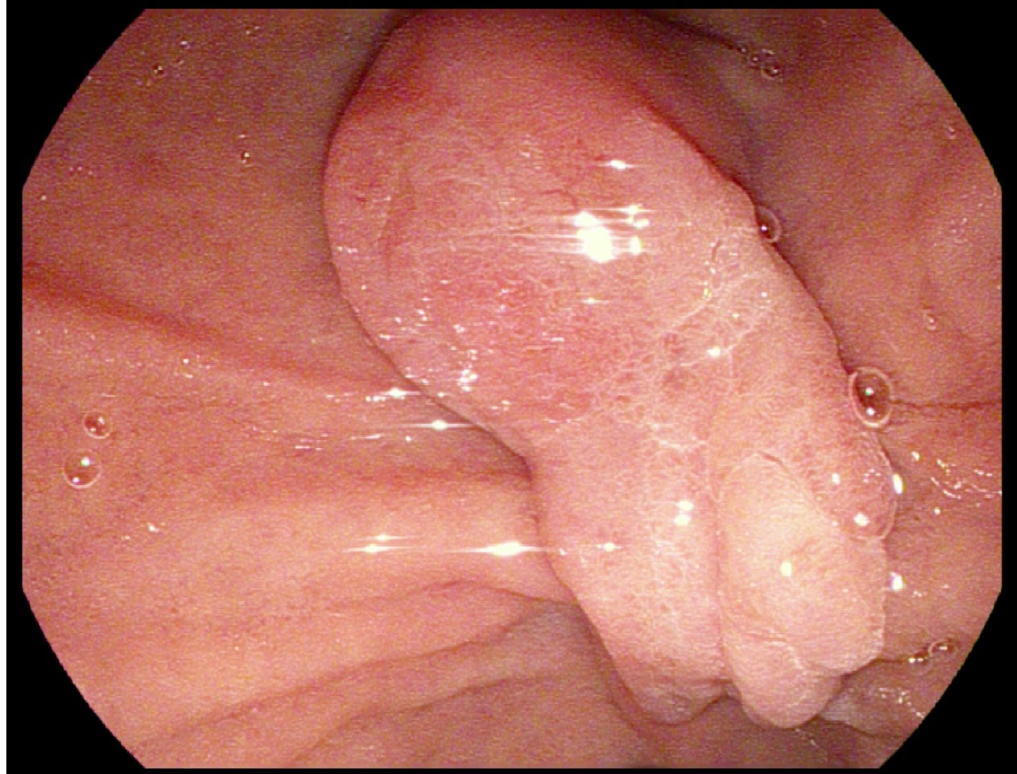
Figure 2. An adenoma of Vater papilla in Standard front-view